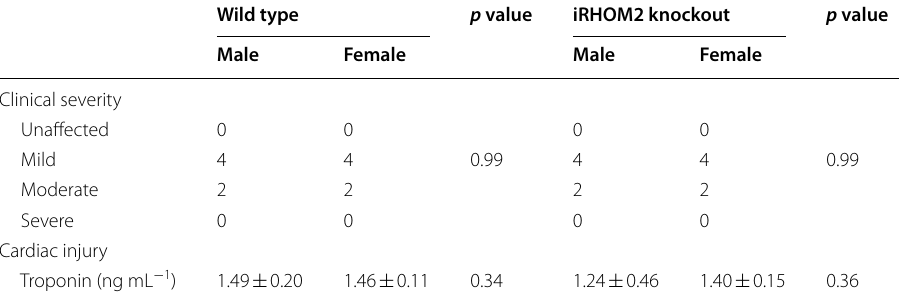
Troponin values are mean